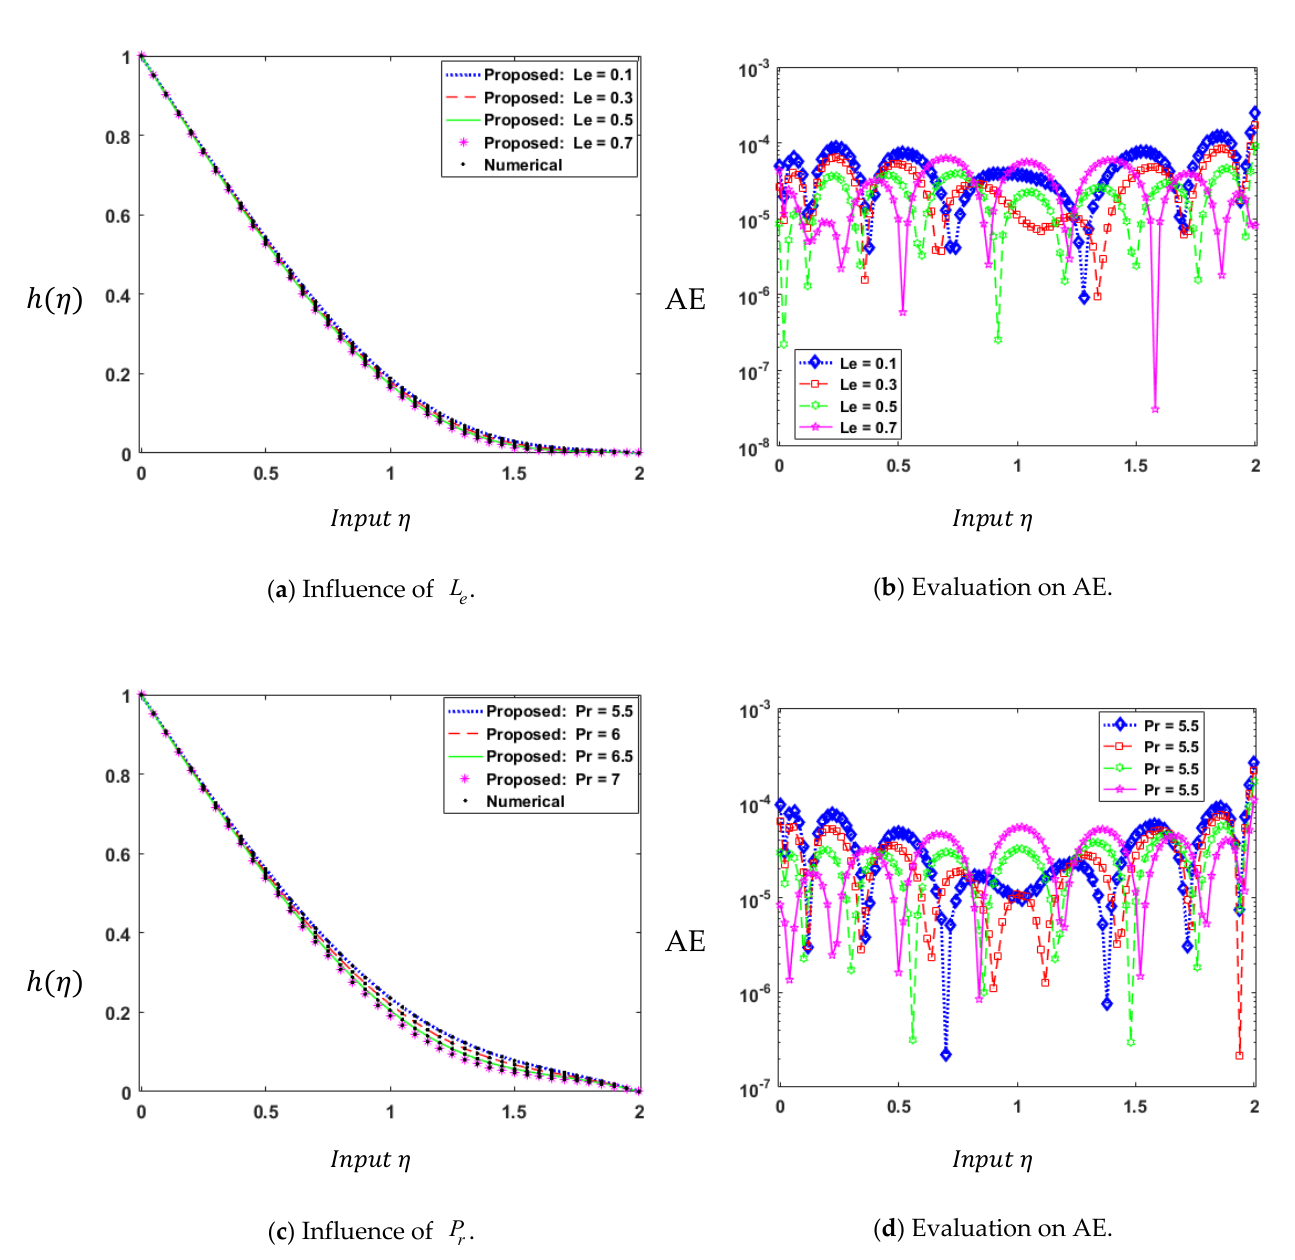
Figure 16. Evaluation of suggested TLMB-NN with outcomes of reference dataset for Scenarios 7 and 8 of HTM-BFN model with MHD.